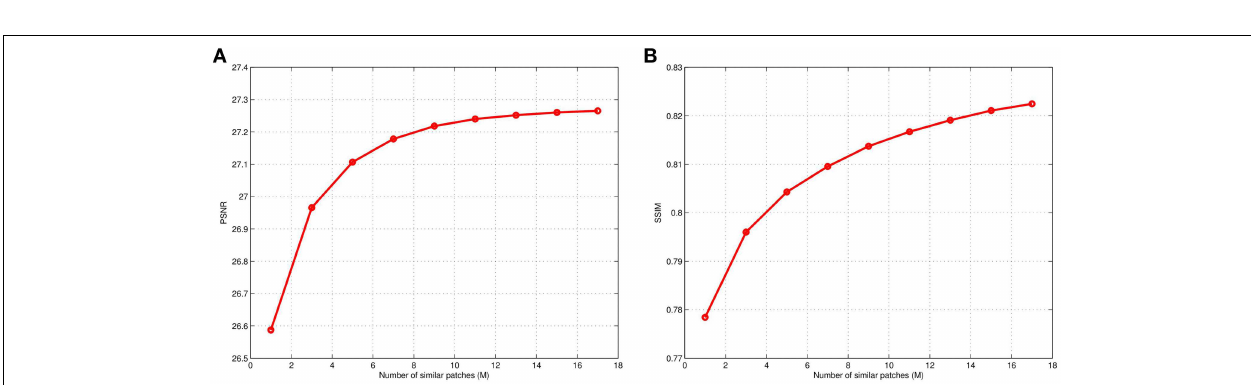
3 , P 9 and σ η 10 . = = =